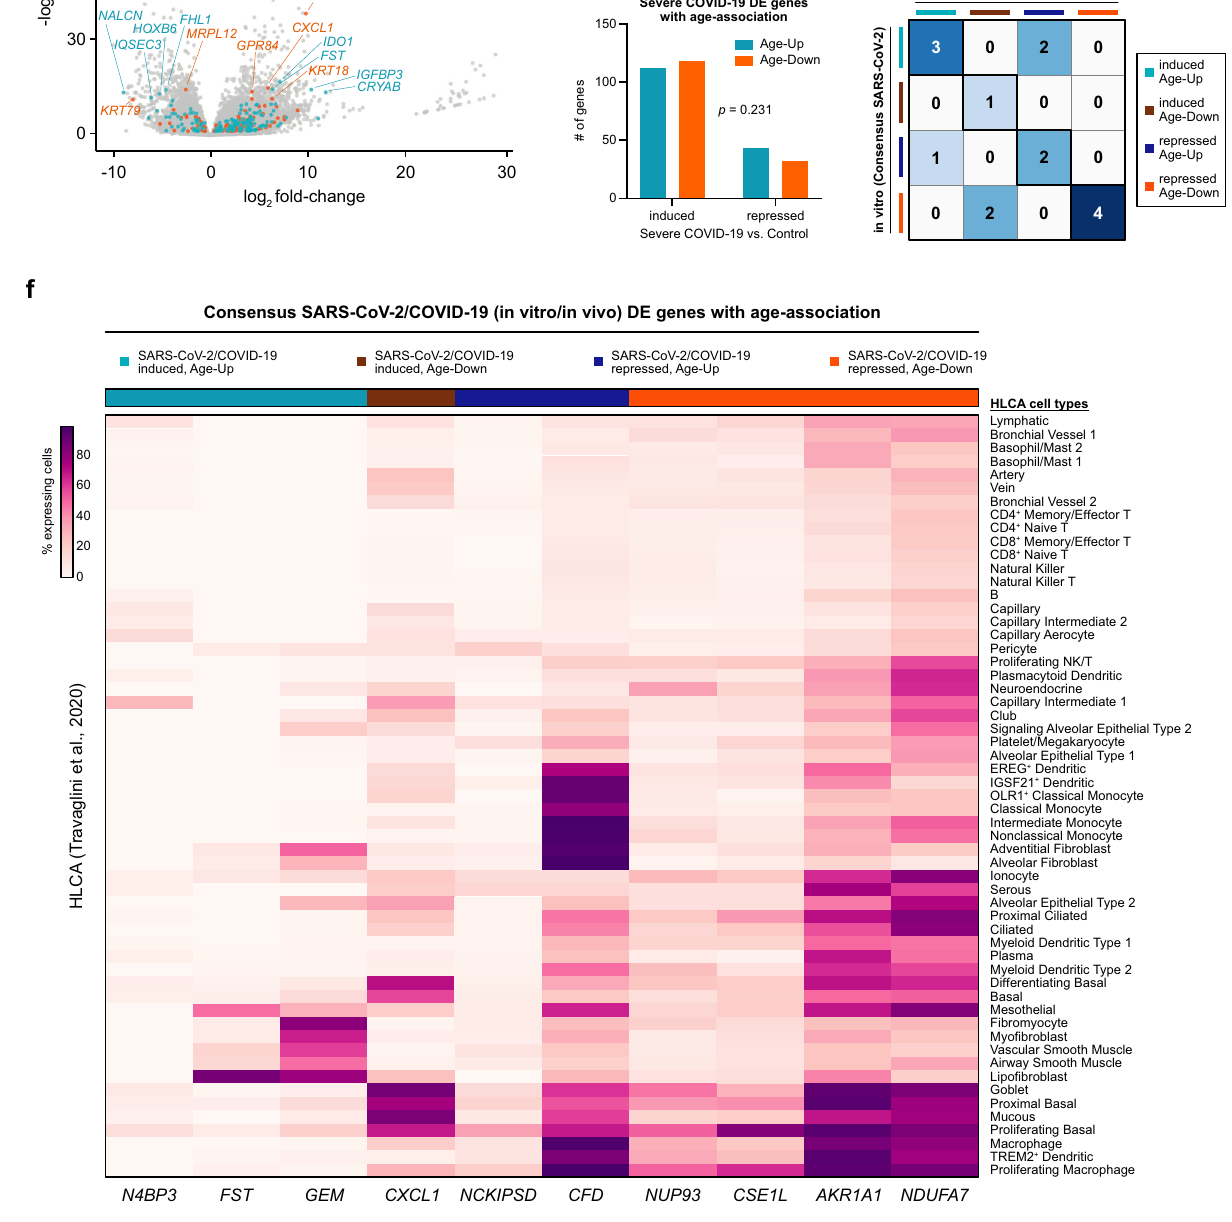
Supplementary Data 27). We again observed that age-associated genes were enriched among the genes differentially expressed in severe COVID-19 patients (Fig. 6b). However, unlike the analysis of SARS-CoV-2 infection in vitro, the directionality of COVID-19 association (induced or repressed) and the